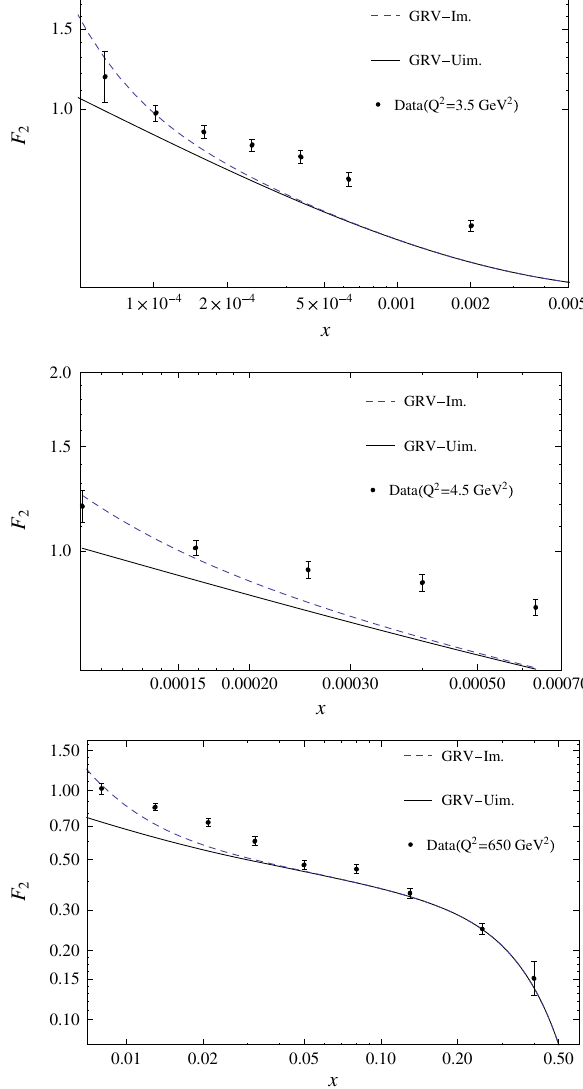
Fig. 2 Our results for the modified nucleon structure function (NSF), F 2 ( x ) , at Q 2 = 3 . 5 GeV 2 , 4 . 5 GeV 2 and 650 GeV 2 , which are com- pared with the available experimental data [64] and the normal GRV parametrization model [51]. Here “GRV-Im.” indicates our results for the modified NSF, using the GRV model. “GRV-Uim.” denotes the nor- mal NSF in the GRV model